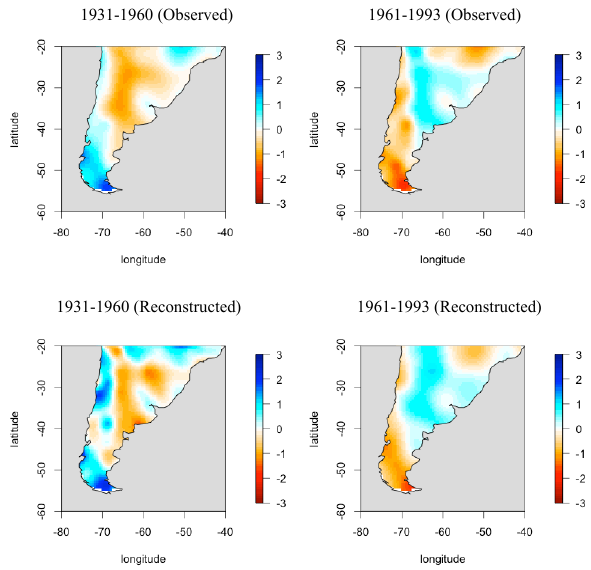
1931-1960 (Observed)